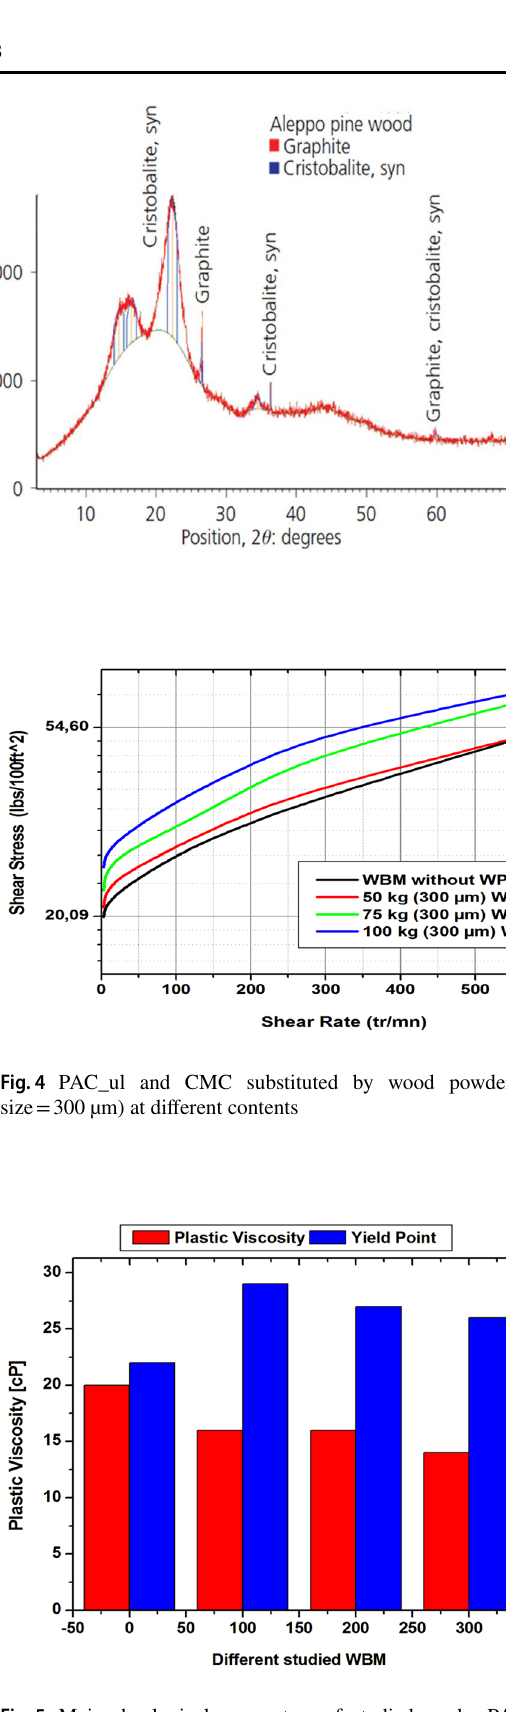
Fig. 5 Main rheological parameters of studied muds: PAC_ul